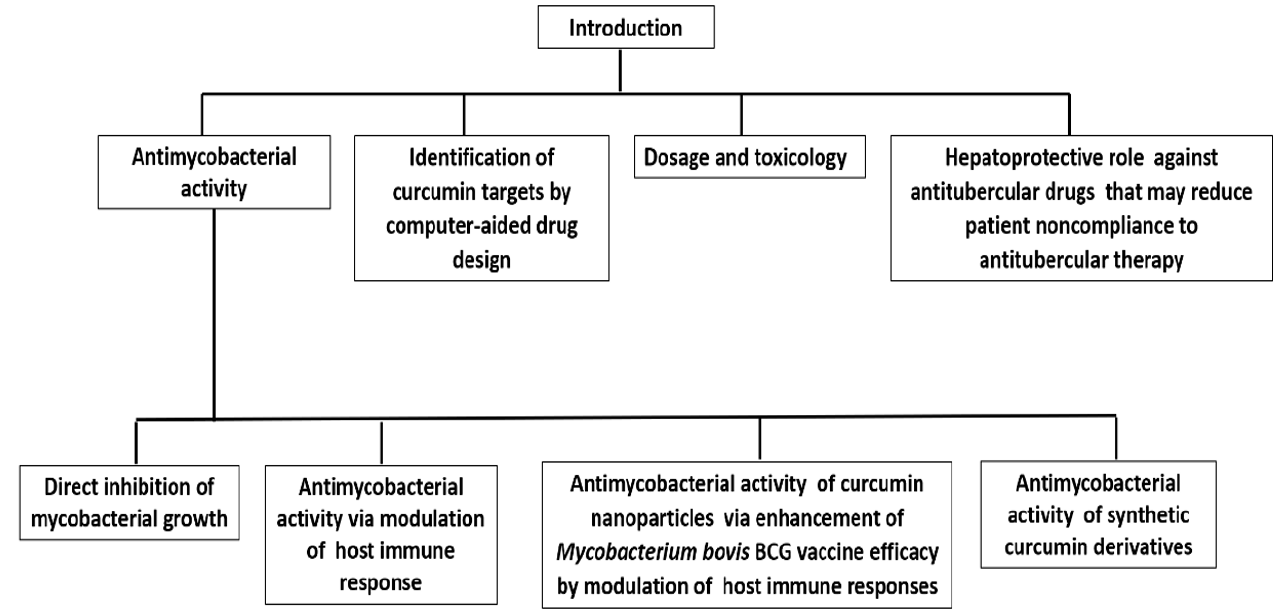
Figure 1. Scheme describing the overview of the review.